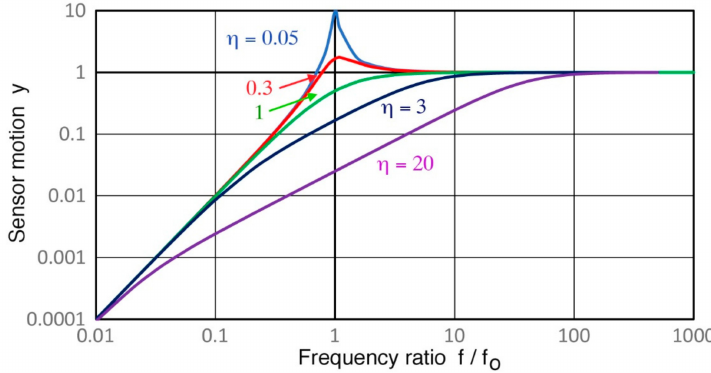
Figure 24. Sensor motion (y) vs. frequency ratio, f/f o , representing the solution of the sensor dynamics equation or DHO model. See Equation